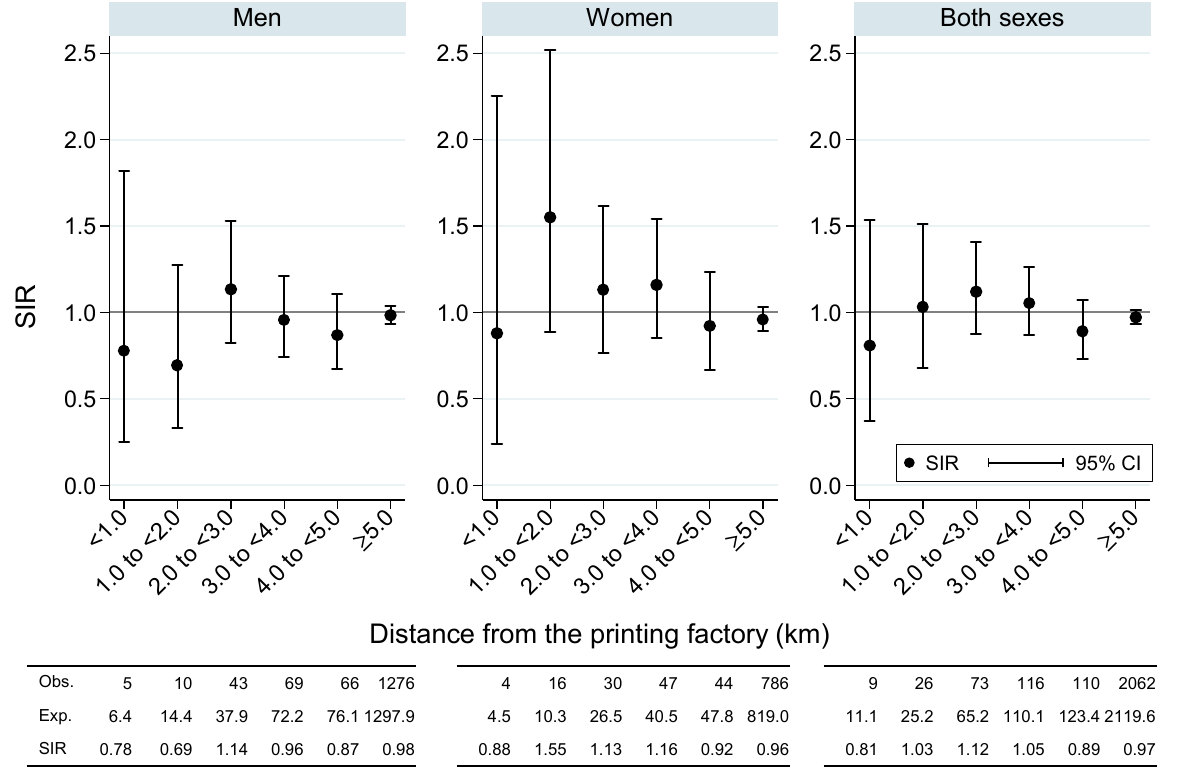
Figure 1. Standardized incidence ratios of residents according to the distance from the printing factory in 2004 – 2007 in Osaka,